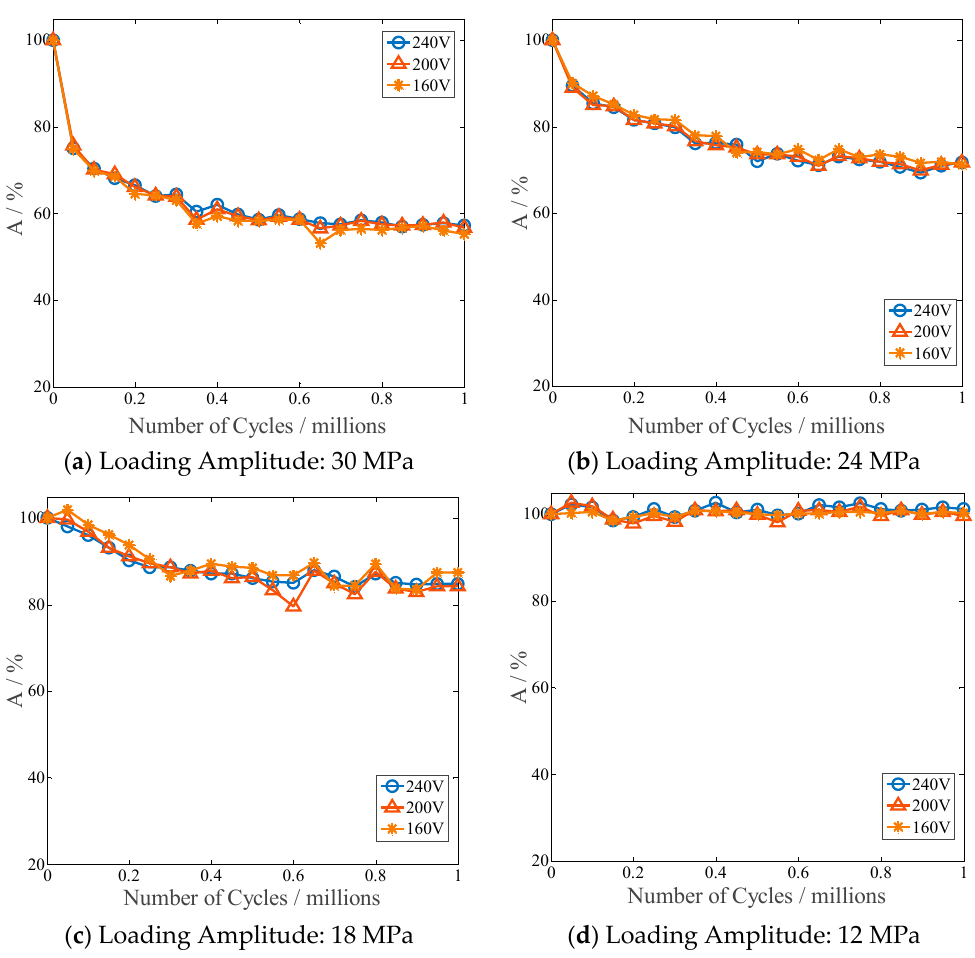
Figure 9. Actuating function index A of MFC actuator versus loading cycles.